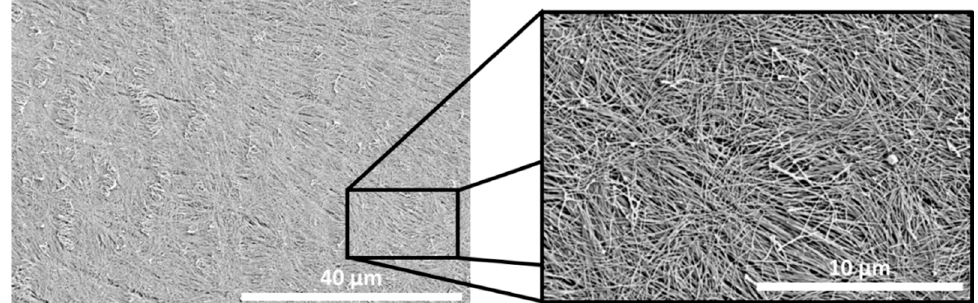
Figure 4. Scanning electron microscope (SEM) images of the human Descemet’s membrane obtained by decellularization of the corneal endothelium.